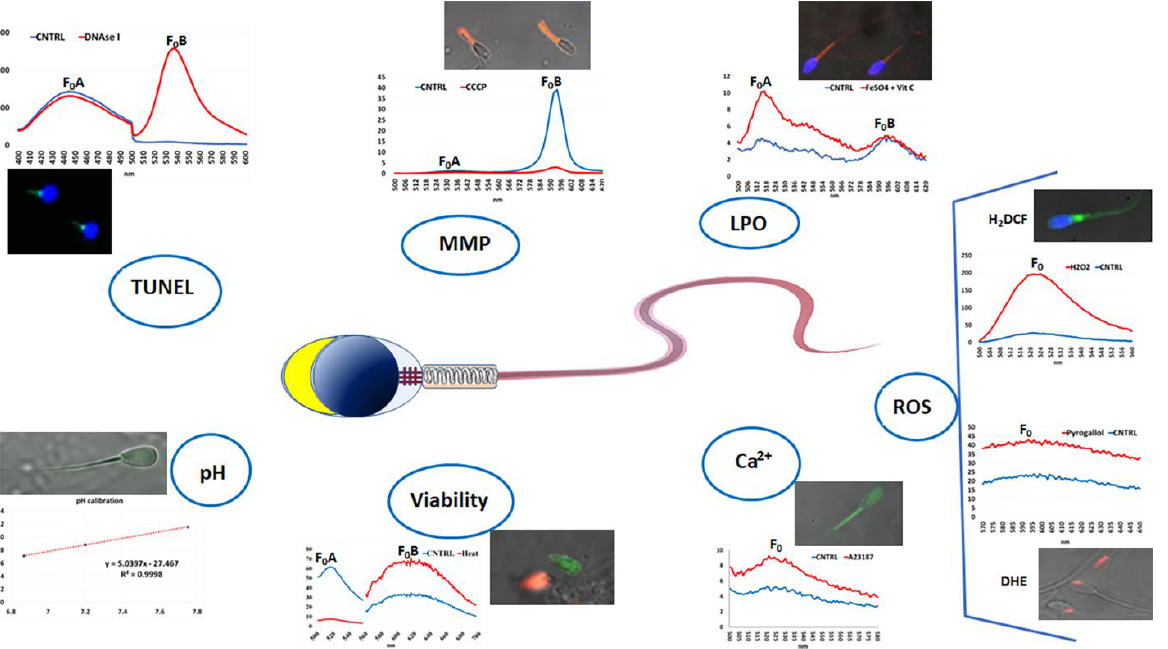
Figure 3. Schematic representation of the fluorescence spectra and photomicrographs of spermato- zoa of different species stained with different fluorescent probes, evaluated by confocal laser mi- croscopy and assessed by fluorescence spectrometry. DNA fragmentation was assessed in mussel sperm by using TUNEL assay and DAPI and comparing the two fluorescent emission peaks; posi- tive controls were obtained by treating sperm with DNAse I. Mitochondrial membrane potential (MMP) was assessed in donkey sperm by JC-1 staining and comparing the two fluorescent emission peaks (FoB/FoB); positive control was obtained by incubating sperm with CCCP. Lipoperoxidation (LPO) was assessed in donkey sperm by C11-BODIPY 581/591 staining and comparing the two fluores- cent emission peaks ((F0A/(FoA + FoB)) x 100); positive control was obtained by incubating sperm with FeSO 4 and vitamin C. Reactive oxygen species (ROS) were assessed in bovine sperm by either H 2 DCF − DA or DHE for evaluating the hydrogen peroxide or superoxide ion content, respectively; positive control samples were obtained by treating sperm with hydrogen peroxide and pyrogallol, respectively. Intracellular calcium content [Ca 2+ ] i was assessed in bovine sperm by Fluo − 4 AM stain- ing; positive controls were obtained by treating sperm with the calcium ionophore, A23178. Viabil- ity in sea urchin sperm was assessed by SYBR-14/PI staining; positive controls were obtaining by treating sperm with heat. Intracellular pH was assessed in bovine sperm by using BCECF − AM; a high correlation coefficient (R 2 ) of the three measurements used to obtain the calibration line ensures the reliability of the method. Fo indicates the emission peak of the fluorescence intensity. Finally, each test was supported by the use of positive controls aimed at increasing or reducing the functionality of the dye target with the detection of the variation in fluo- rescence intensity. For this purpose, the analysis aimed at evaluating the MMP, based on JC-1 dye, used the carbonyl cyanide 3-chlorophenylhydrazone (CCCP), a protonophore that, uncoupling the oxidative phosphorylation in mitochondria, causes a decrease in MMP, shifting down the second fluorescent emission peak at ~595 nm [160]. For LPO de- tection based on the C11-BODIPY 581/591 lipophilic fluorophore, the samples used as posi- tive controls are incubated with FeSO 4 and ascorbic acid [182]; this treatment causes an increase in the first fluorescent emission peak at ~520 nm and a decrease in the second fluorescent emission peak at ~590 nm [160]. For ROS detection, positive controls are ob- tained by incubating cell samples with either oxygen peroxide or pyrogallol/menadione when 2 ′ ,7-dichlorodihydrofluorescein diacetate (H 2 DCF-DA) or dihydroethidium (DHE) dyes are used [176,180]; with both treatments, the fluorescent emission peak at ~530 and ~600 nm, respectively, largely increased. For [Ca 2+ ] i evaluated by Fluo-4 AM dye, a very rapid incubation with a Ca 2+ ionophore, such as A23187, represents an efficient positive control [160]. For DNA fragmentation, as recommended by TUNEL kit manufacturer,